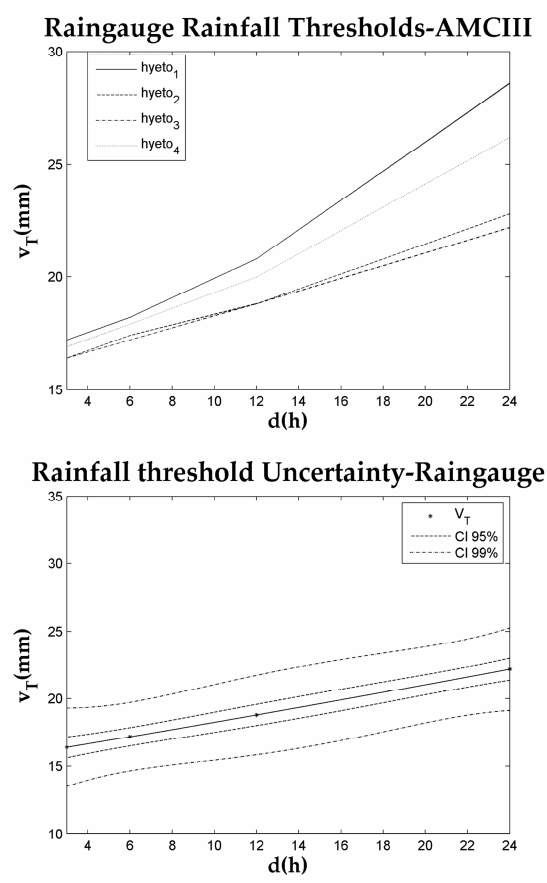
Fig. 9. Threshold values evaluated by a hydrological model cali- brated with raingauge data for AMCIII soil conditions (upper panel) and uncertainty associated with hyeto1 threshold for the Mignone River basin (lower